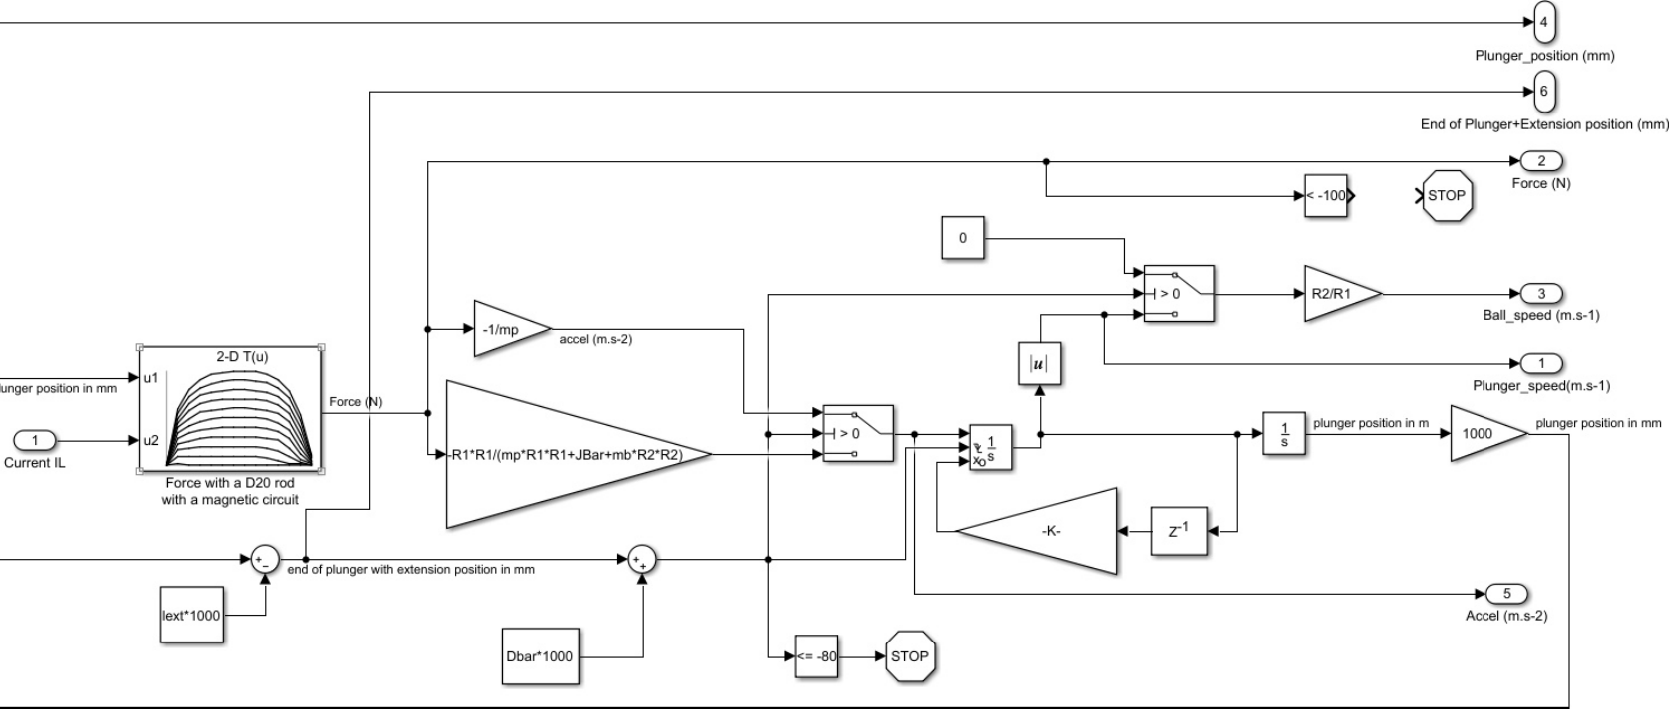
Figure 13. Mechanical part of the coil gun